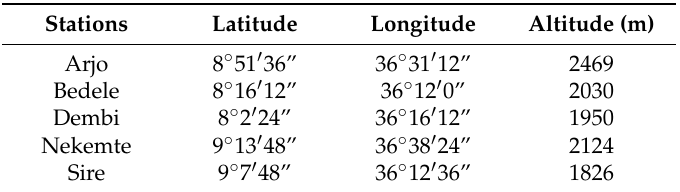
Table 1. List of meteorological stations and their respective data points.